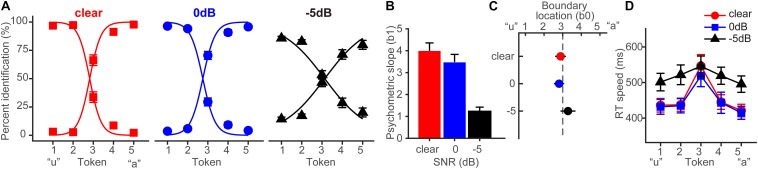
Behavioral speech categorization is robust to noise interference. (A) Perceptual psychometric functions for clear and degraded speech identification. Curves show an abrupt shift in perception when classifying speech indicative of discrete perception (i.e., CP). (B) Slopes and (C) locations of the perceptual boundary show speech categorization is robust even down to 0 dB SNR. (D) Speech classification speeds (RTs) show a categorical pattern for clear and 0 dB SNR speech; participants are slower at labeling ambiguous tokens (midpoint) relative to those with a clear phonetic label (endpoints) (Pisoni and Tash, 1974; Bidelman and Walker, 2017). A categorical RT effect is not observed for highly degraded speech (–5 dB SNR). errorbars = ± s.e.m. Figure adapted from Lewis and Bidelman (2020).